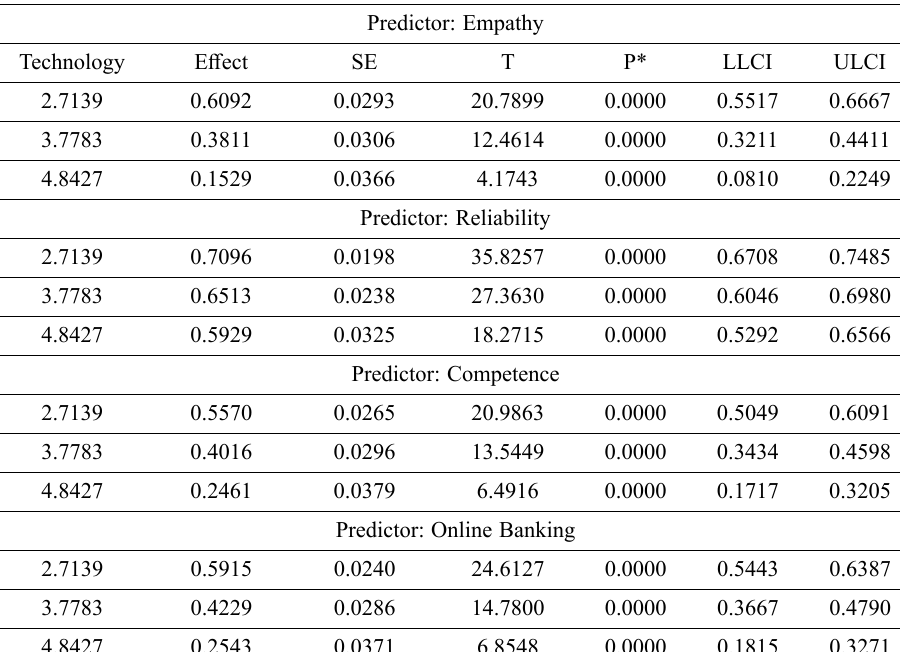
Table 10. Conditional